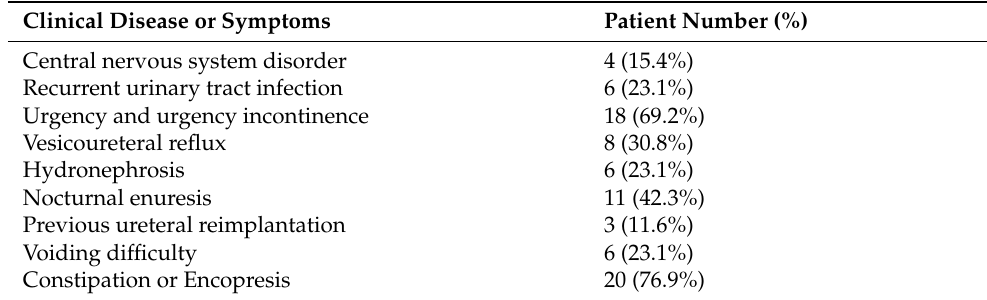
Table 1. Baseline demographics of the 26 children with dysfunctional